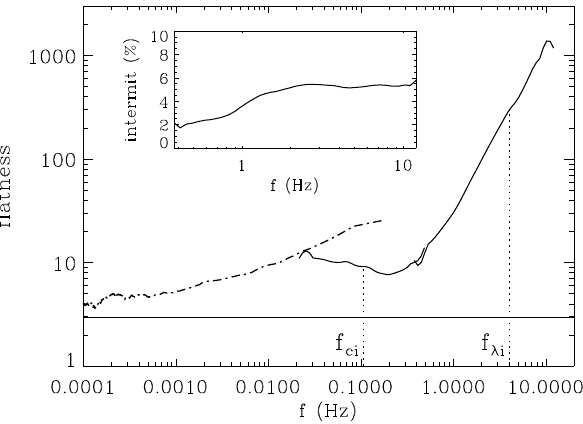
Figure 111: The fourth-order moment 𝐾 ( 𝑓 ) of magnetic fluctuations as a function of frequency 𝑓 is shown. Dashed line refers to data from Helios spacecraft while full line refers to data from Cluster spacecrafts at 1 AU. The inset refers to the number of intermittent structures revealed as da function of frequency. Image reproduced by permission from Alexandrova et al. (2008), copyright by